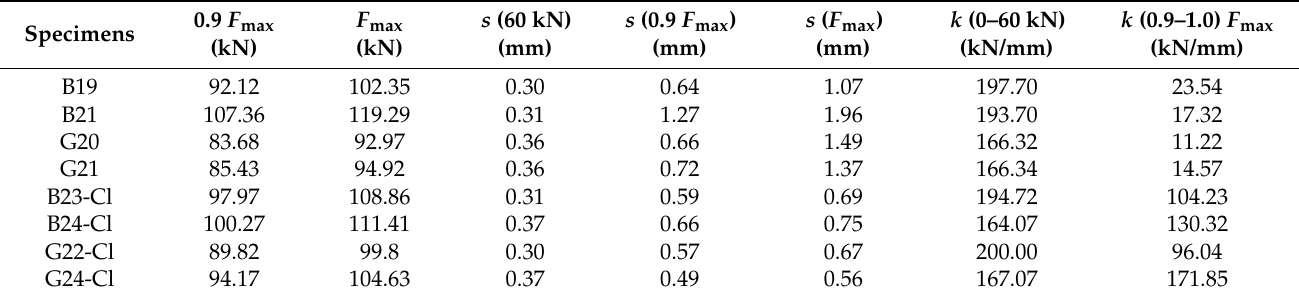
Table 6. Typical parameters determined from the graphs in Figure 12, based on the analysis of the relationship between the pull-out force F [kN] and shifts s [mm] of rebars: 0.9 F max and F max —90% and 100% respectively, of the maximum pull-out force, s (60 kN), s (0.9 F max ) and s ( F max )—shift s of the rebar from the concrete specimen for the force of 60 kN, 90% F max and F max , k (0–60 kN) and k [(0.9–1.0) F max ]—stiffness k of the adhesive bond between the rebar and concrete for the force values within the range of 0–60 kN and 90–100% of the force F max